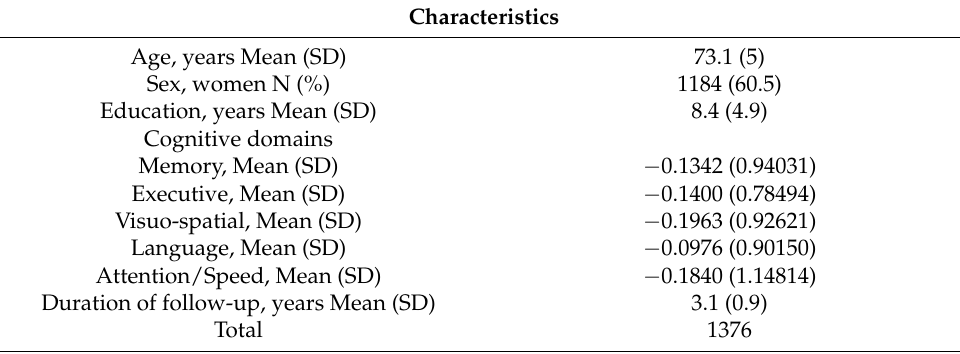
Figure 1. Flowchart of our sample based on available data and follow-up visits. Table 1. Characteristics of the participants at